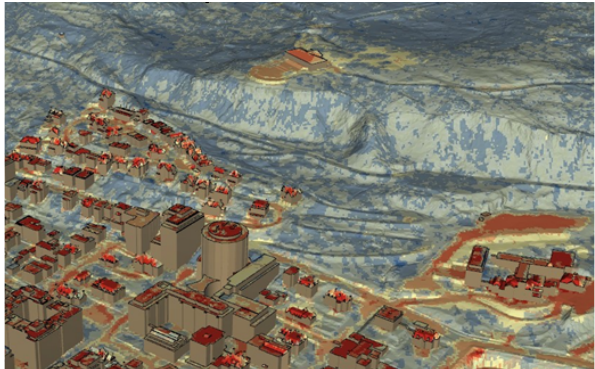
Figure 5. Environment Canada models atmospheric dispersion (CUDM, 2007) using VdM 3D city models